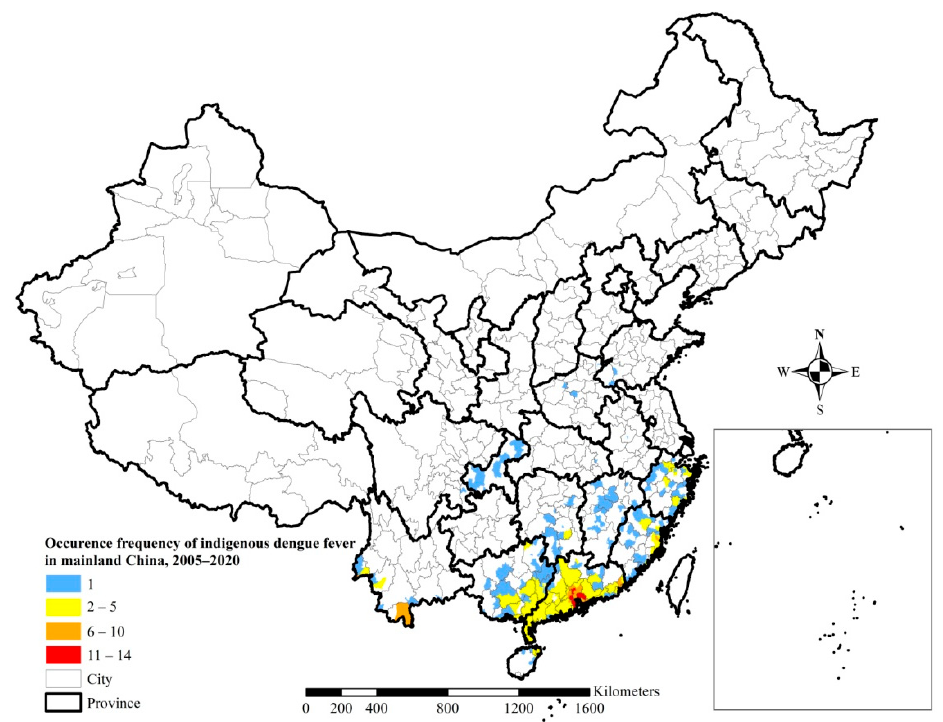
Figure 3. Occurrence frequencies of indigenous dengue fever in mainland China, 2005–2020.